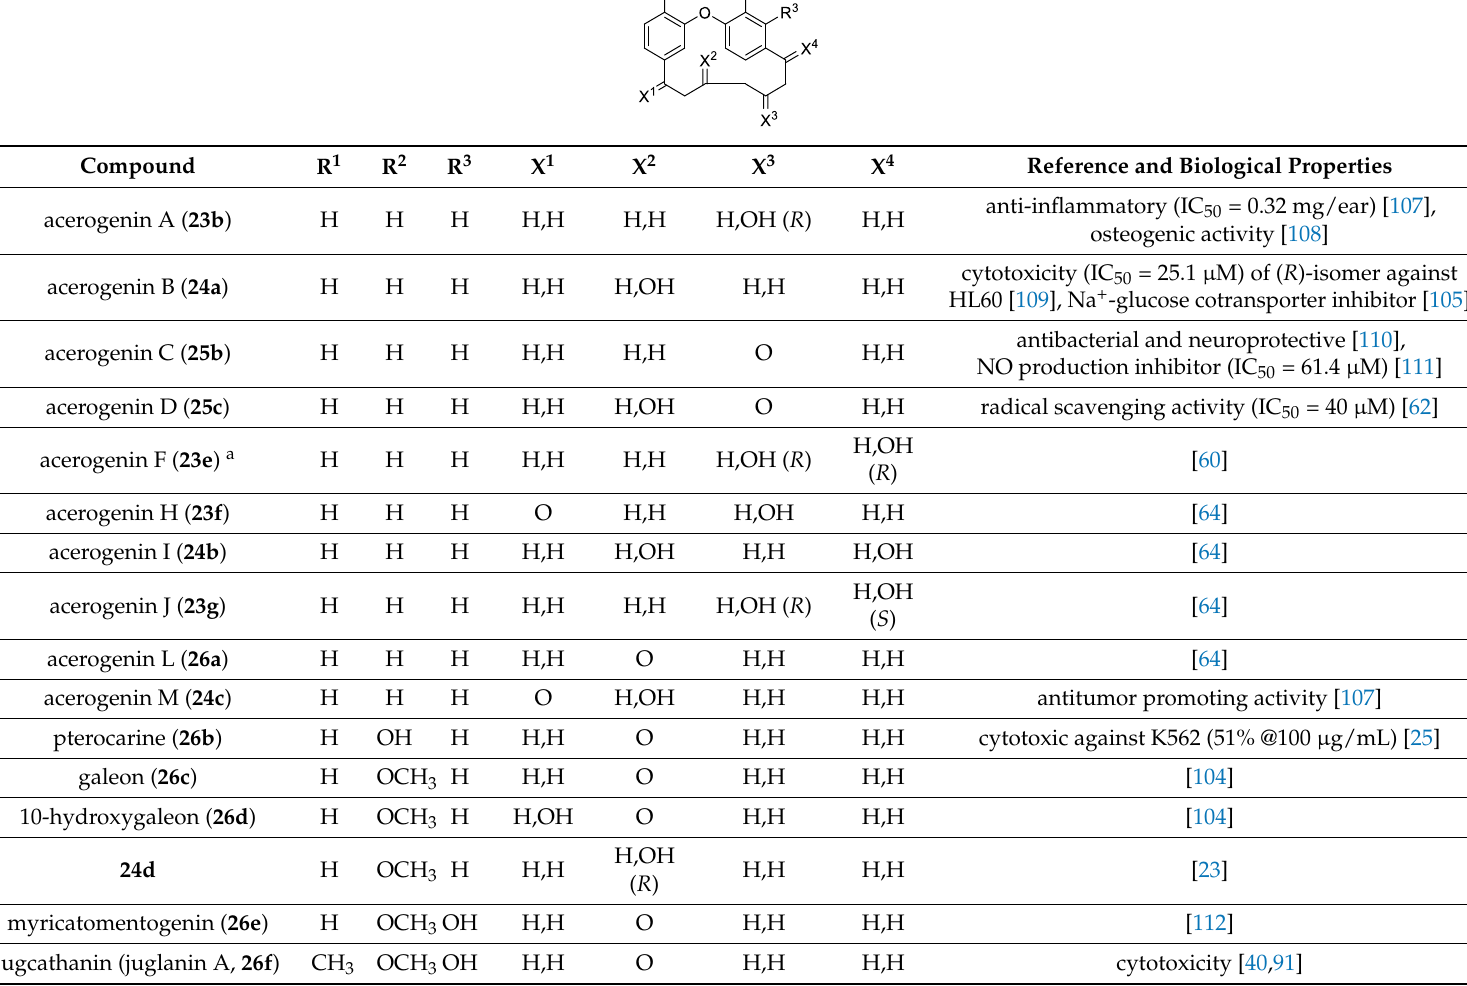
Table 5. The acerogenins with diphenyl ether heptanoid skeleton and their biological properties.